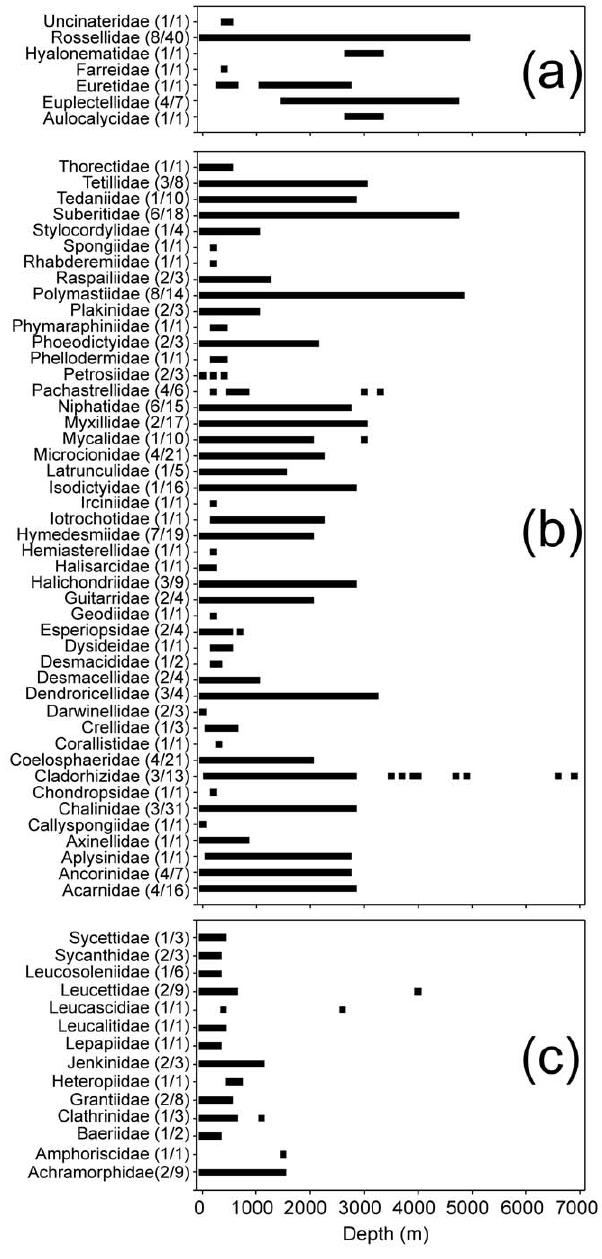
Figure 7. Depth ranges of each sponge family within their respective class. Hexactinellida (a), Demospongiae (b), and Calcarea (c) in the Southern Ocean. Brackets after family name indicate firstly the number of genera within that family, and secondly, number of species within that family.